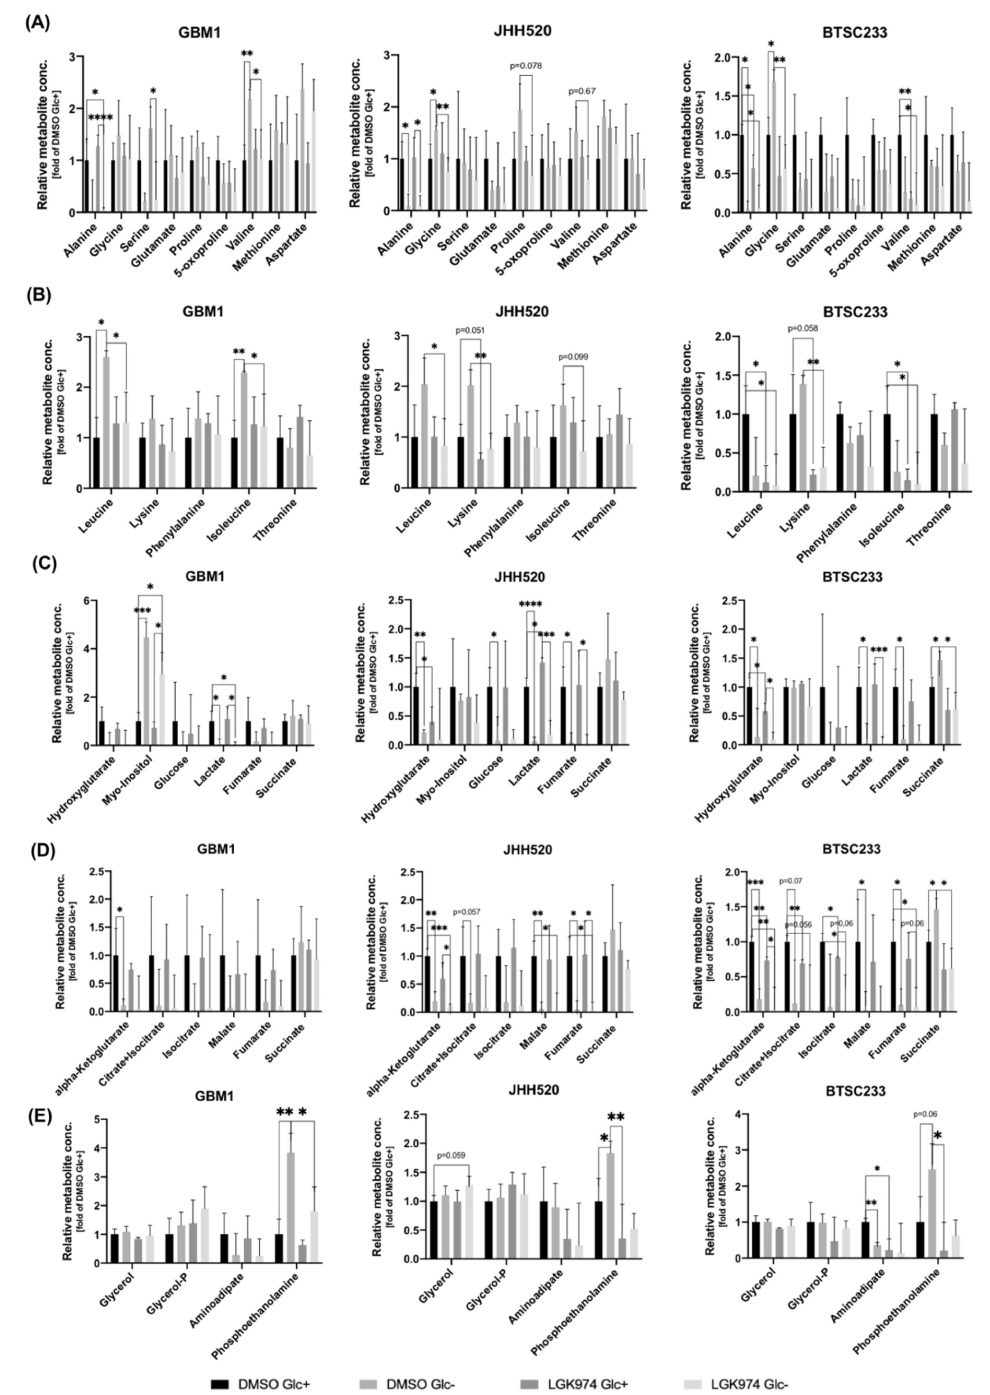
Figure 5. LGK974 treatment and/or glucose starvation-altered intracellular metabolite